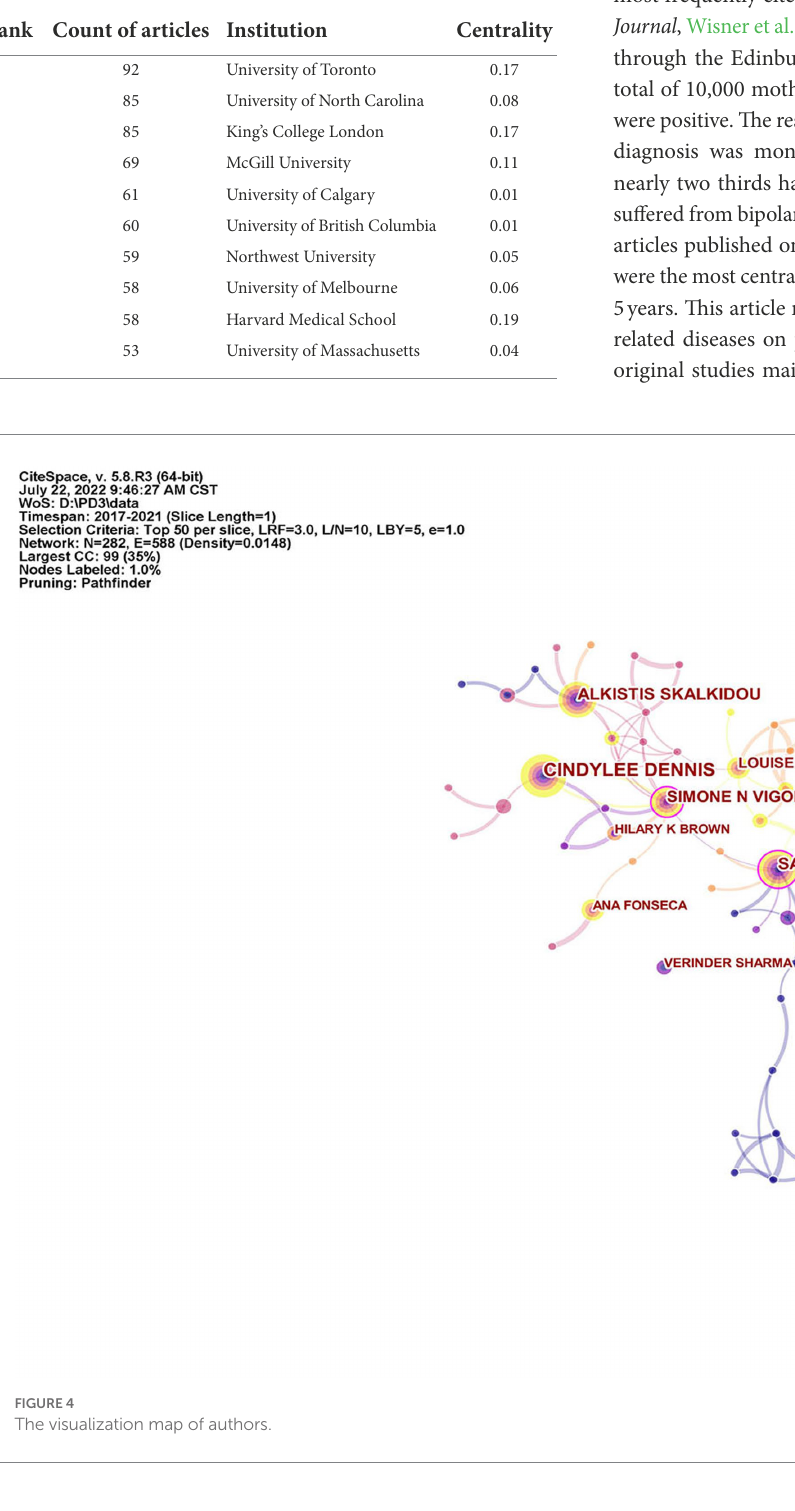
TABLE 2 Top 10 productive institutions in the field of PPD.